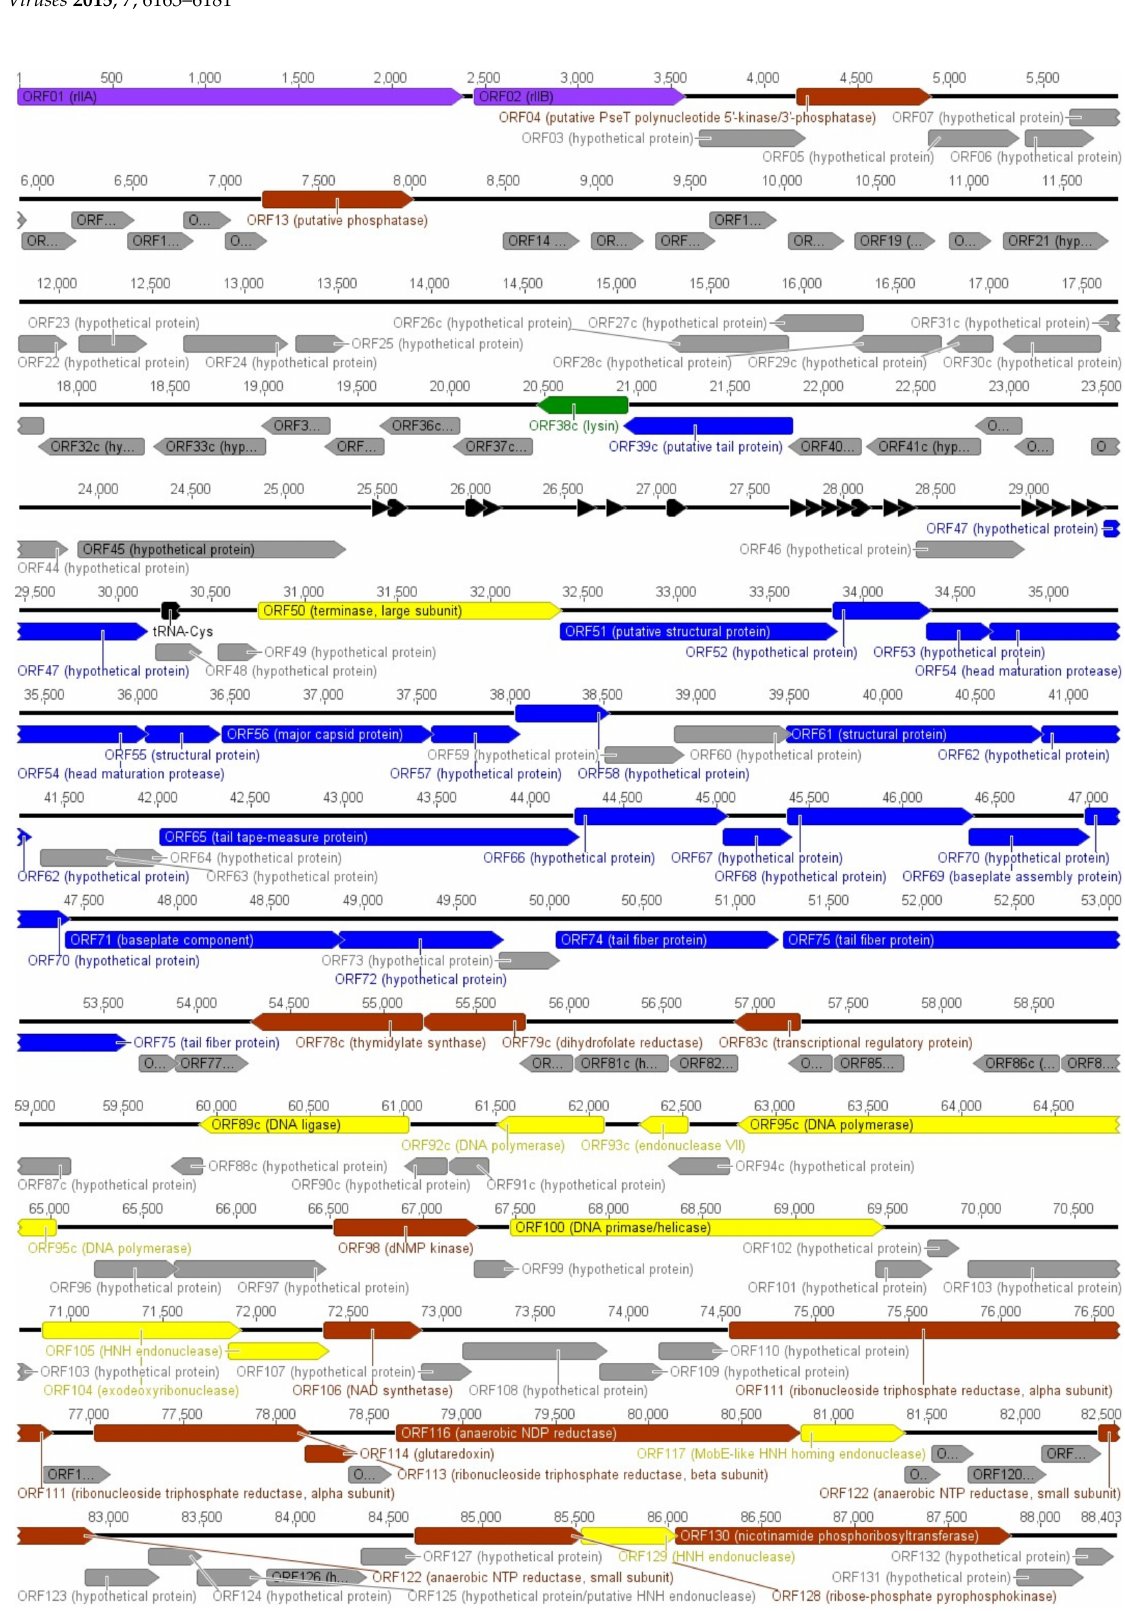
Figure 4. Functional genome map of phage VpaE1. Functions are assigned according to the characterized ORFs in NCBI database and/or MS/MS analysis. The color code is as follows: yellow — DNA replication, recombination, repair and packaging; brown — transcription, translation, nucleotide metabolism; blue — structural proteins; green — lysis; purple — phage-host interaction; and grey — ORFs of unknown function black — tRNA.